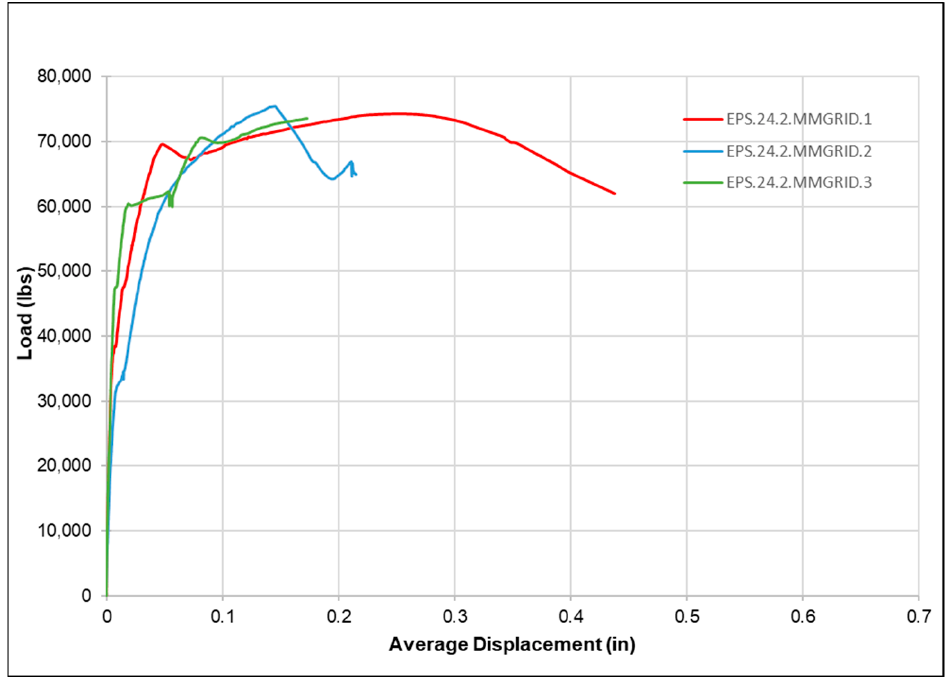
Figure 15. Average displacement behavior for each of the three specimens having 2 in (51 mm) EPS.